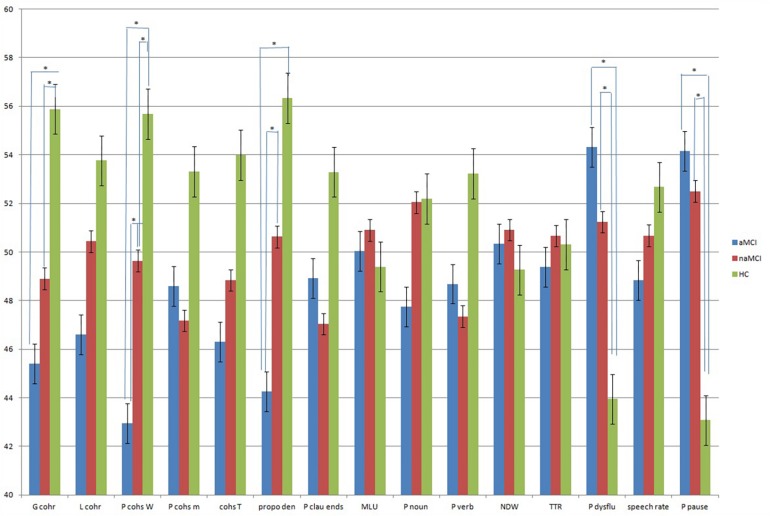
Comparison ofdiscourse measures with converted T score in aMCI, naMCI, and HC. Asterisks (∗) indicate discourse measures with significant group differences.